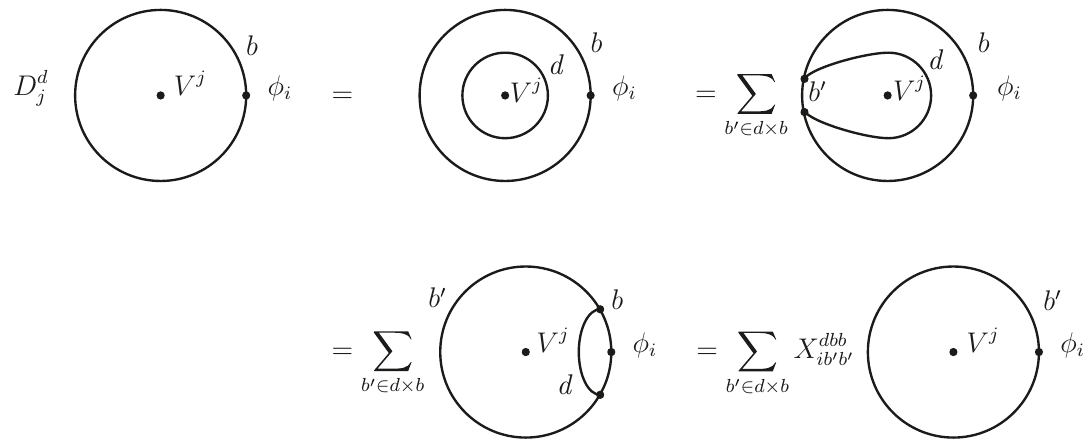
Figure 18 . Two equivalent ways of computing a bulk-boundary correlator in presence of a closed string defect d